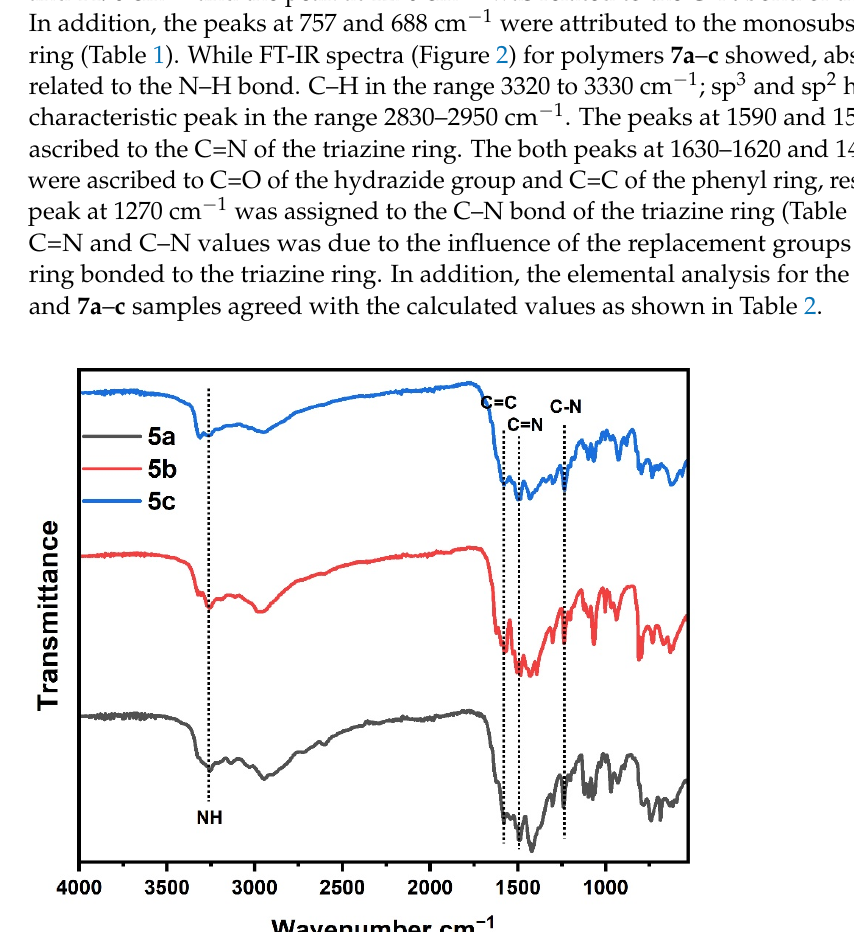
Table 1. FT-IR data for prepared polymers 5a-c & 7a-c. Compd.